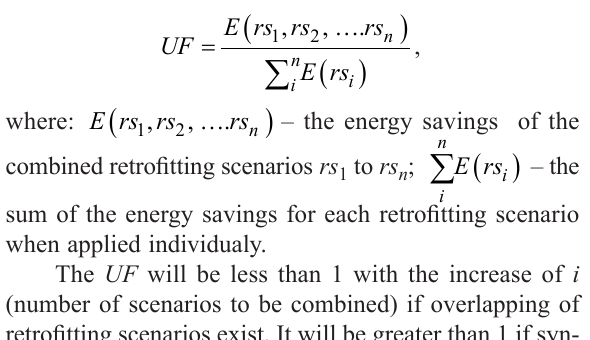
Fig. 3. Case study